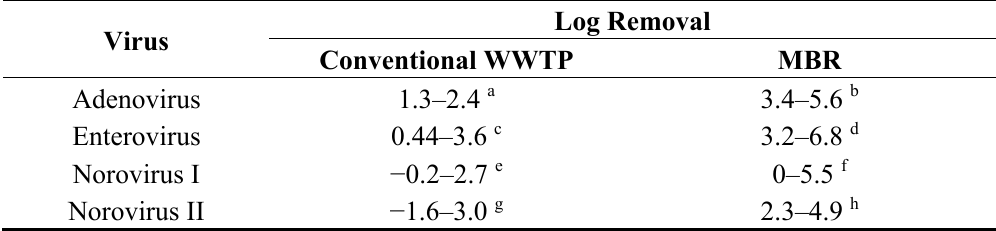
Table 4. Reported virus removal in full-scale wastewater treatment plants